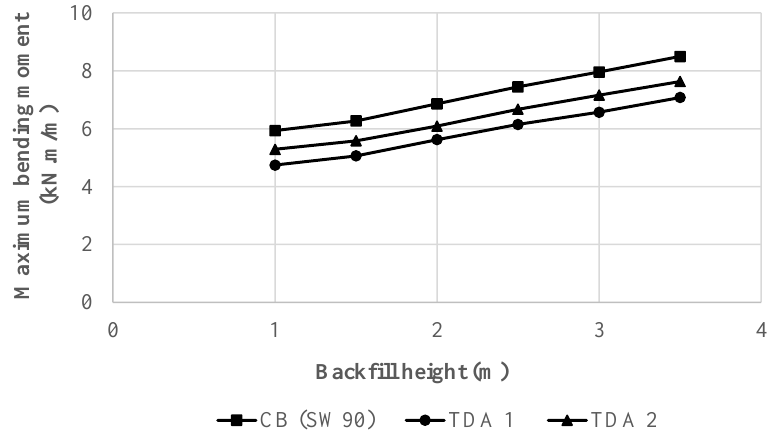
Figure 7. Effect of the backfill height on the maximum bending moment for the three trench configurations considering the SW90 as a backfill soil.